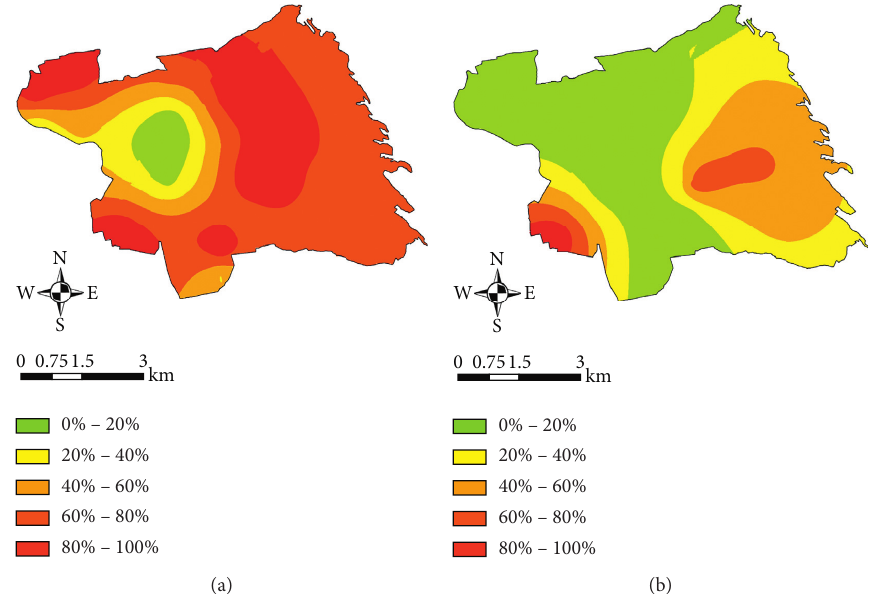
Figure 9: Liquefaction probability map. (a) Prob. of exceedance having LPI ≥ 5 in 50 years and (b) prob. of exceedance having LPI ≥ 15 in 50